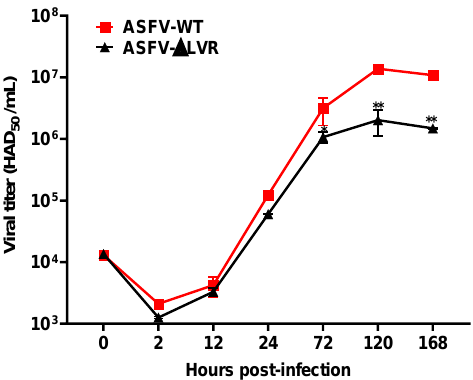
Figure 4. The viral growth of the LVR-deleted ASFV mutant in PAMs. PAMs were infected with ASFV-WT or ASFV- ∆ LVR (MOI = 0.01), and virus titers yields were determined at the indicated time points post-infection. The data are presented as the mean ± SD of three independent experiments. (* p < 0.05; ** p < 0.01).